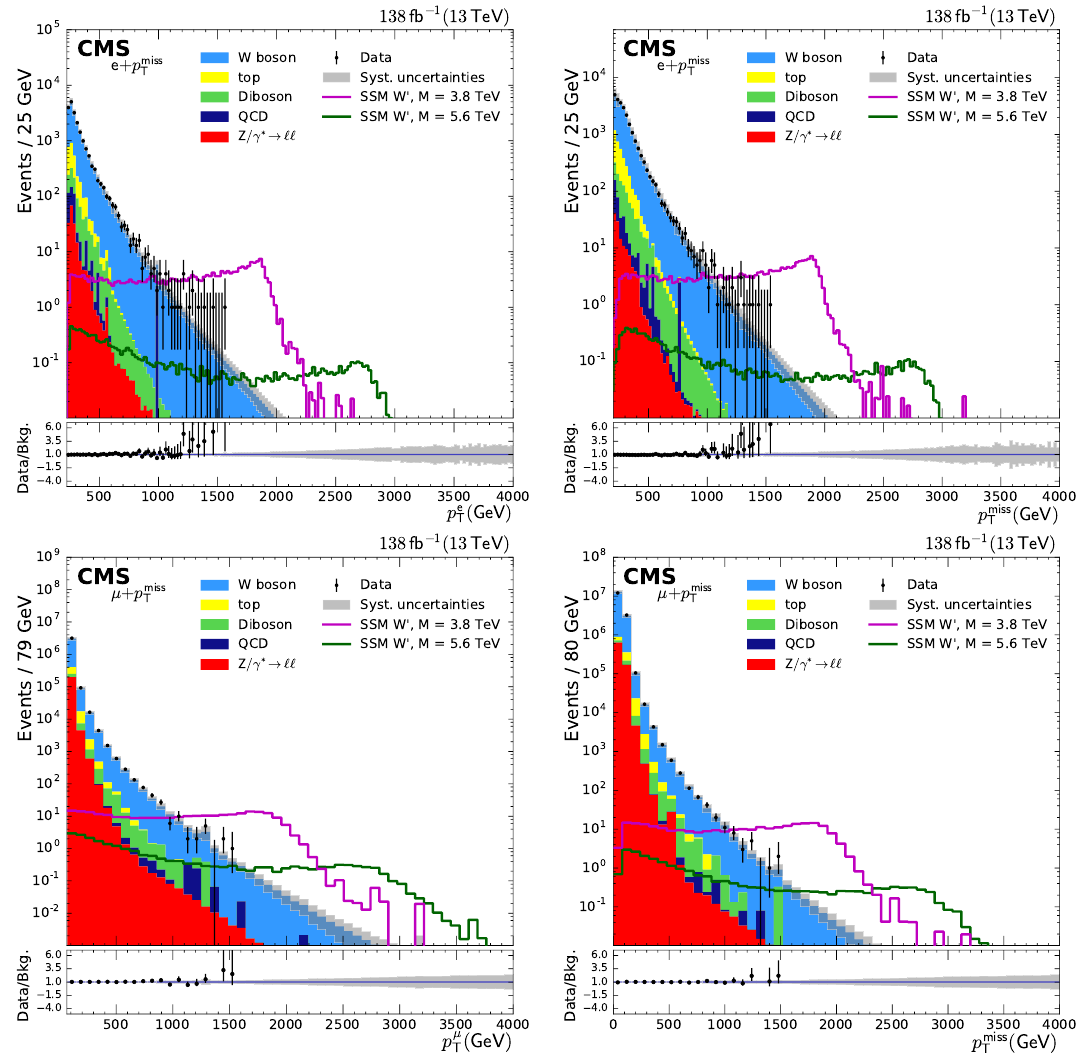
(left) and p miss (right) for the electron (upper) and Figure 3 . The distributions for lepton p T T muon (lower) channels after applying the full selection criteria, for the combined 2016–2018 data sets. Two signal distributions are presented, corresponding to SSM W 0 boson masses of 3.8 and 5.6 TeV. The lower panels show the ratios of data to the SM prediction, and the shaded bands represents the systematic